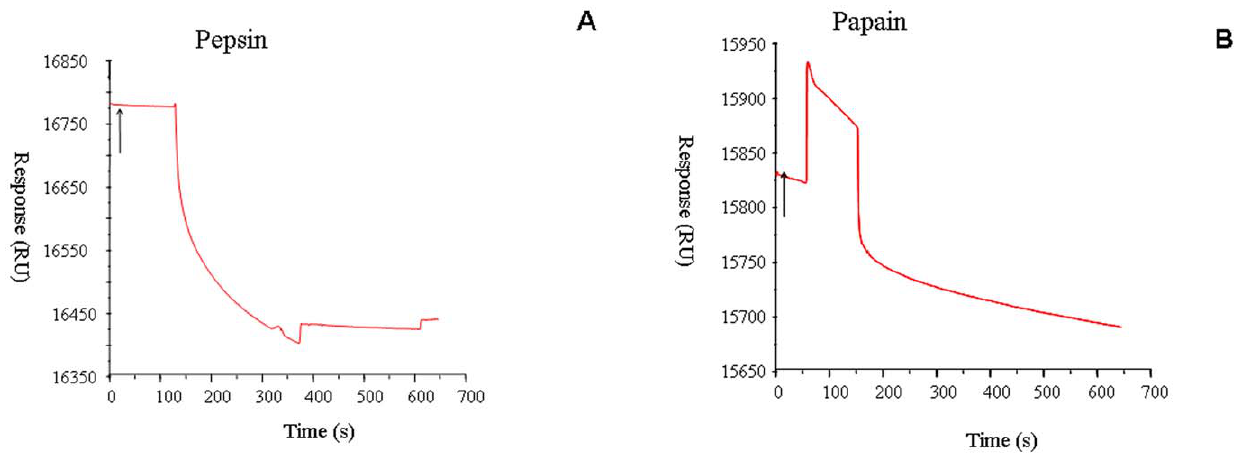
Figure 6. SPR sensograms of HE-4 interaction with papain and pepsin. Concentrations of HE-4 were fixed at 10 m M. Concentrations of papain and pepsin were 75 nM. Injection time of papain and pepsin is indicated by an arrow. ( A ) Pepsin-HE-4 interaction. ( B ) Papain-HE-4 interaction.